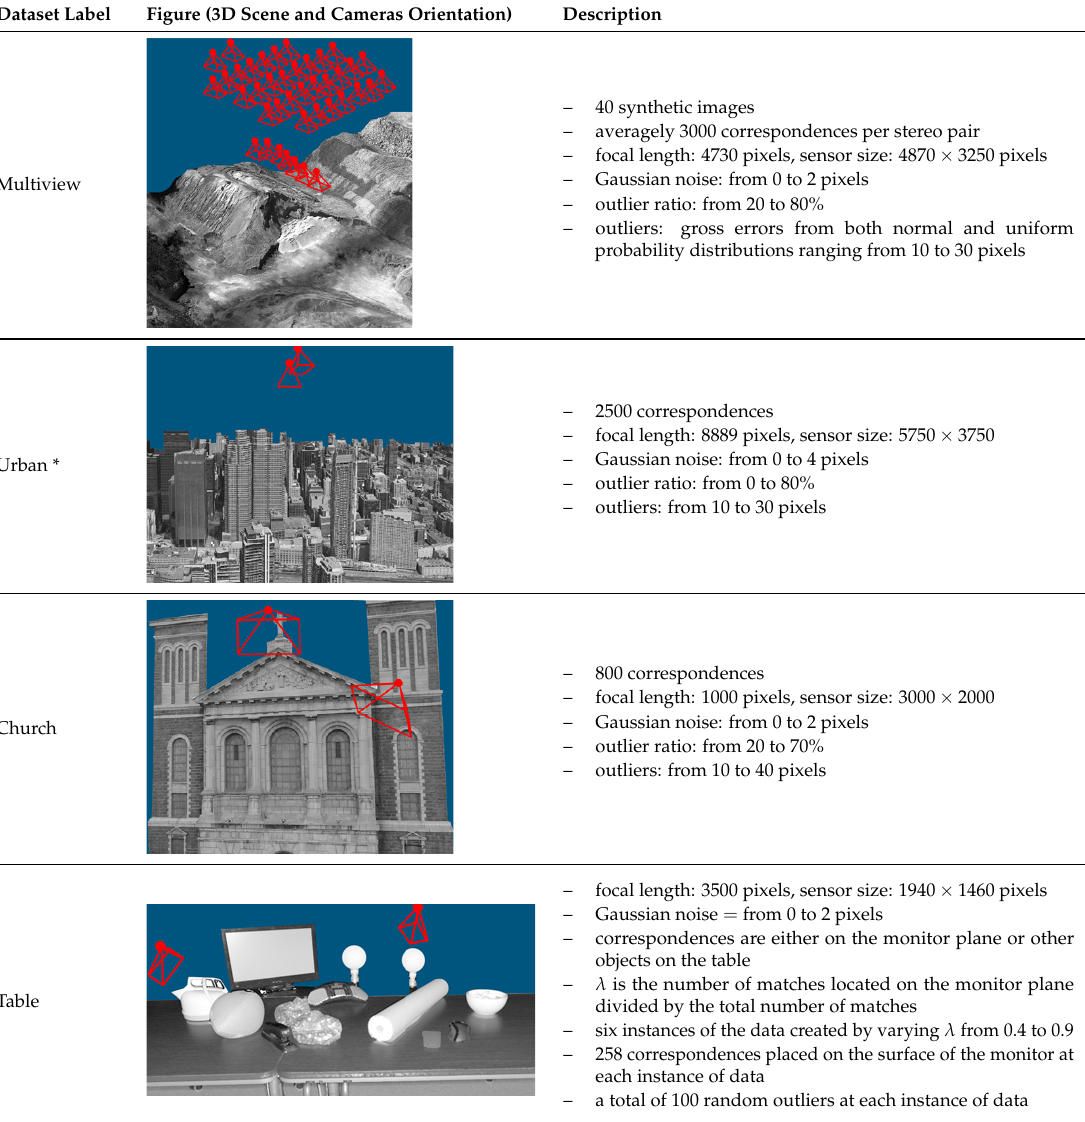
Table 2. Description of synthetic datasets.